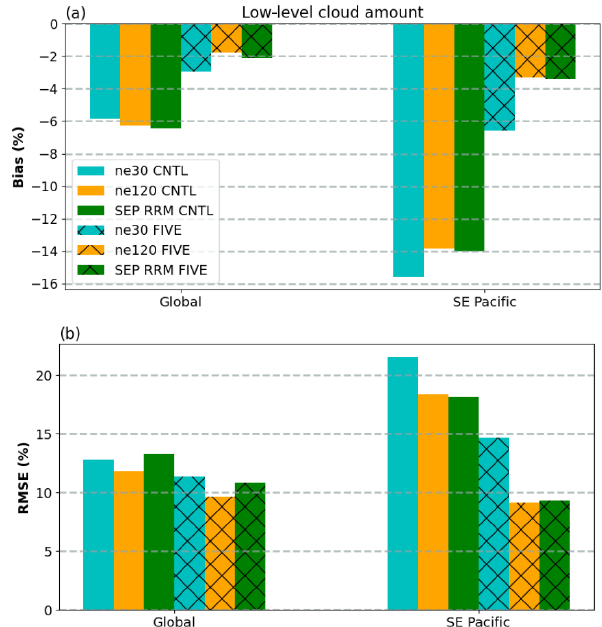
Figure 6. (a) Bias and (b) root mean squared error (RMSE) of low-level cloud amounts for each simulation computed relative to CALIPSO observations. Each skill metric is computed for the global domain (left) and the SE Pacific region (right), as bounded by the box in Fig. 4e. We note that, for skill scores computed for the SE Pacific region, only ocean columns (which we define as columns having a less than 0.5 land fraction) are considered to focus on scores for marine boundary layer clouds. Hatched bars represent simulations run with